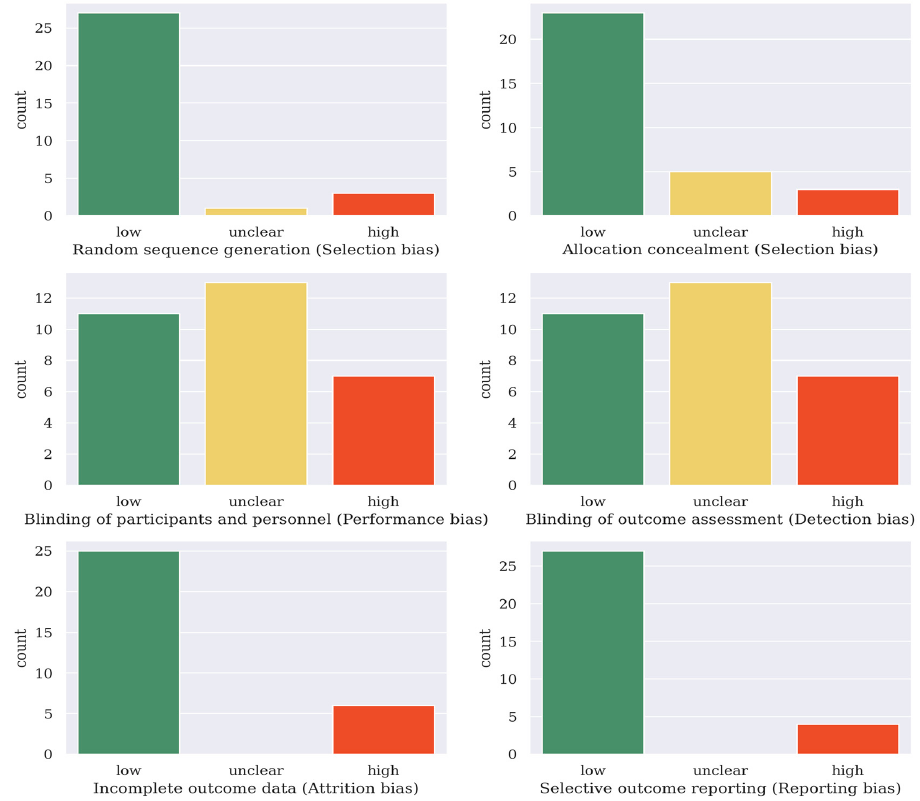
Figure 1. Risk of bias assessment result of the 31 deep learning articles covered in this survey (Cochrane’s collaboration tool